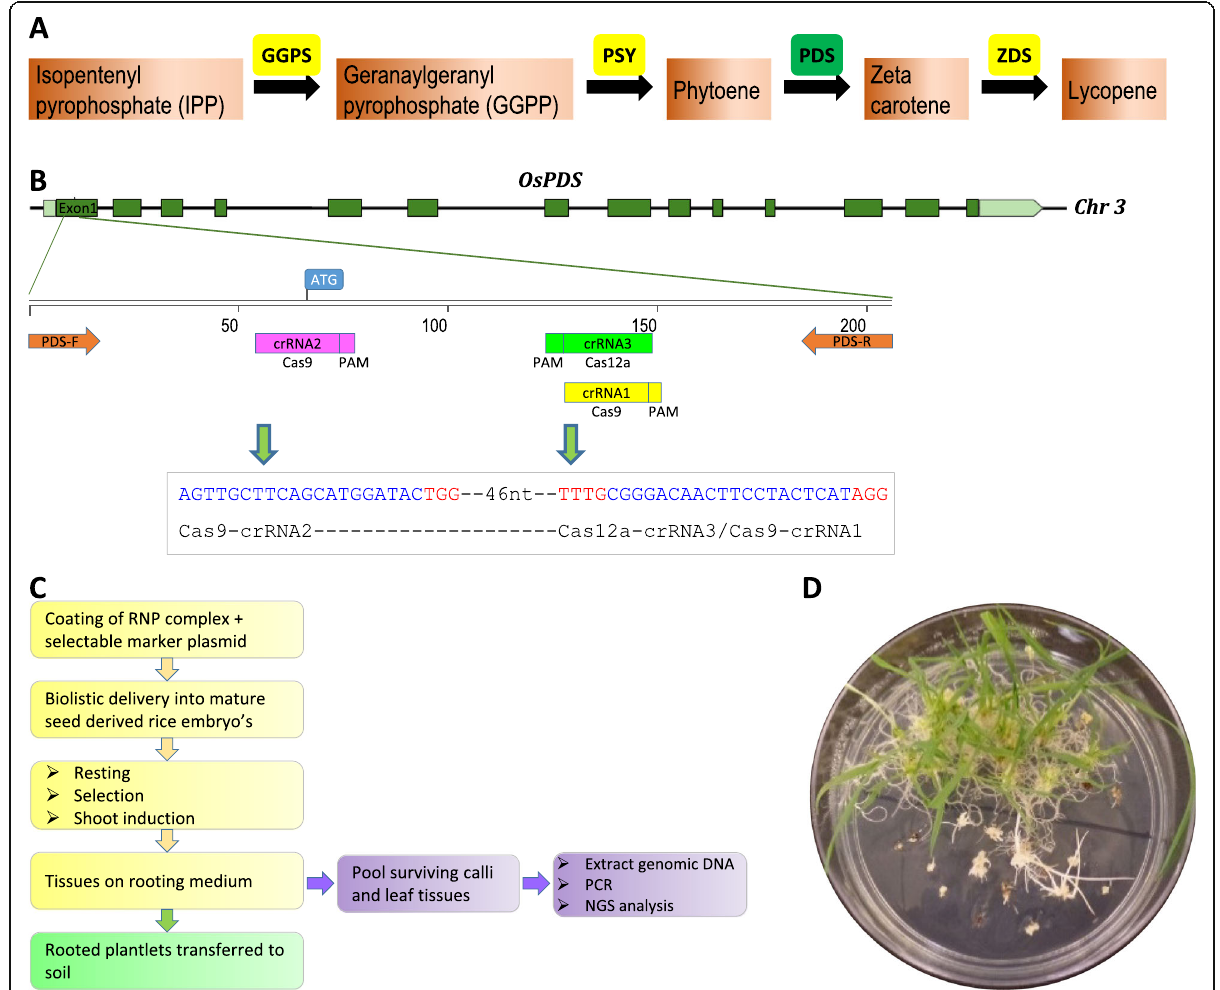
Fig. 1 Choice of Carotenoid biosynthesis pathway to evaluate CRISPR-Cas nucleases. a Carotenoid biosynthesis pathway in rice. Phytoene desaturase (PDS) is a single copy gene involved in the synthesis of zeta-carotene from phytoene. GGPS, geranylgeranyl pyrophosphate synthase; PSY, phytoene synthase; PDS, phytoene desaturase; ZDS, zeta-carotene desaturase. b Schematic diagram showing OsPDS gene structure, OsPDS-Exon1 and relative position of crRNA1/2 for CRISPR-Cas9 and crRNA3 for CRISPR-Cas12a. PDS-F and PDS-R, forward and reverse primer pair for PCR and NGS analysis. c Flowchart showing RNP complex delivery and editing efficiency comparison analysis. d Regenerating green and albino rice plantlets on hygromycin containing rooting medium